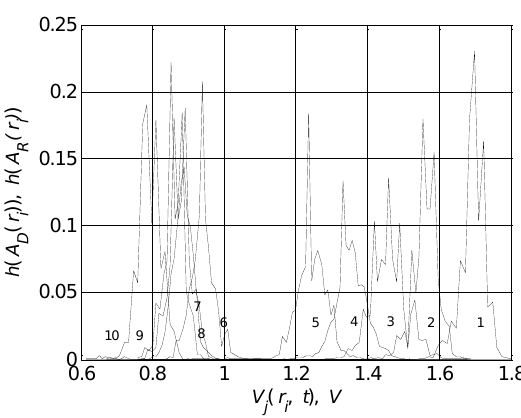
Fig. 3. Distributions of amplitudes for direct h ( A D ( r i )) (curves 1 – r 1 = 32 m , 2 – r 2 = 16 m , 3 – r 3 = 8 m , 4 – r 4 = 4 m , 5 – r 5 = 2 m ) and reflected path pulses h ( A R ( r i )) (curves 6 – r 5 = 2 m , 7 – r 4 = 4 m , 8 – r 3 = 8 m , 9 – r 2 = 16 m , 10 – r 1 = 32 m